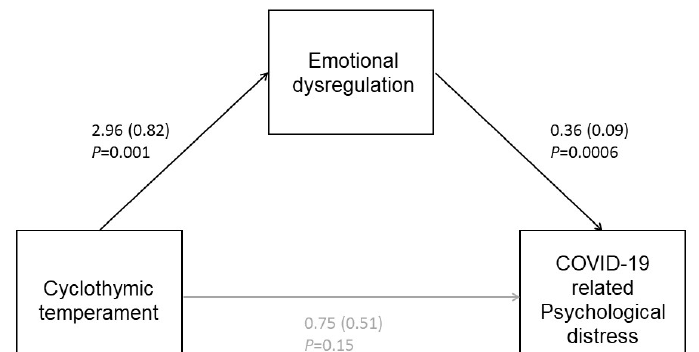
Figure 1. The mediation model showed the link between cyclothymic temperament and psychological distress, with the intervention of emotional dysregulation.